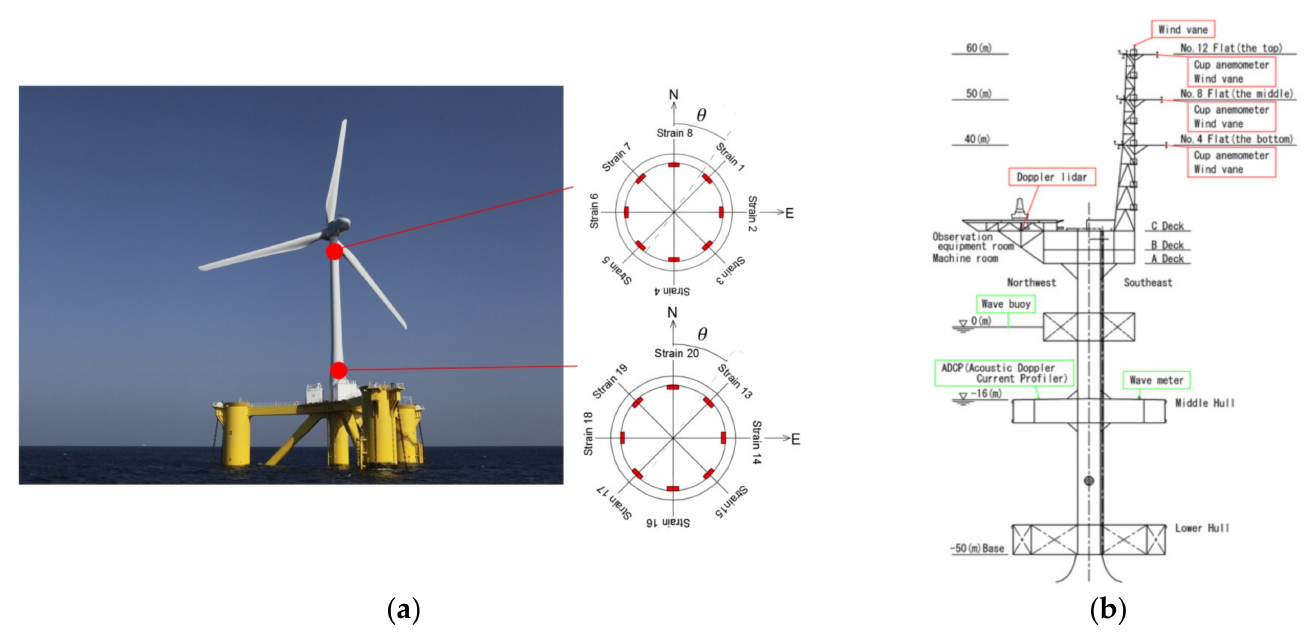
Figure 4. Overview of 2 MW floating wind turbine and measurement systems. ( a ) 2 MW wind turbine ( Fukushima Mirai ), ( b ) floating substation ( Fukushima Kizuna